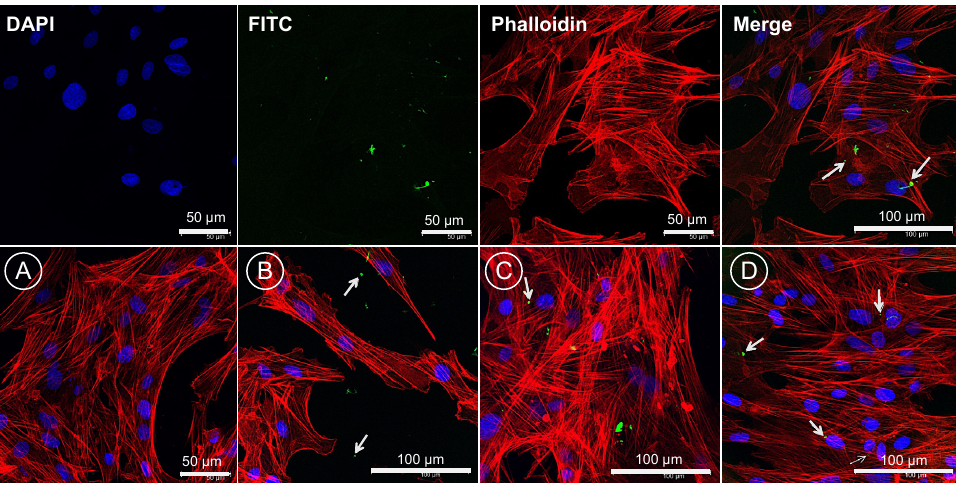
Figure 12. Confocal Laser Scanning microscope (CLSM) images of cellular localization of CS-PLGA particles. The images in the top row show 24 h-treated FKD-1-R cells with FITC-labelled CS-PLGA particles (green), cytoplasmic actin filaments (red) and nuclear counterstain (blue). The images in the bottom row represent the confocal images of ( A ) negative control (particles-free wells), ( B ) particles localized intercellularly, ( C ) adsorption of the particles on cell membrane, and ( D ) perinuclear localization of the particles. The green fluorescence of FITC-labeled particles is indicated by arrows.